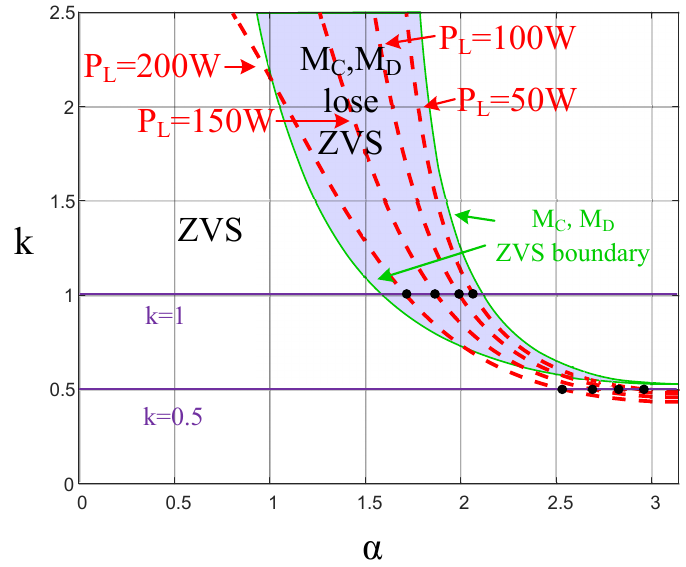
Figure 8. The ZVS region and the power lines of k and α